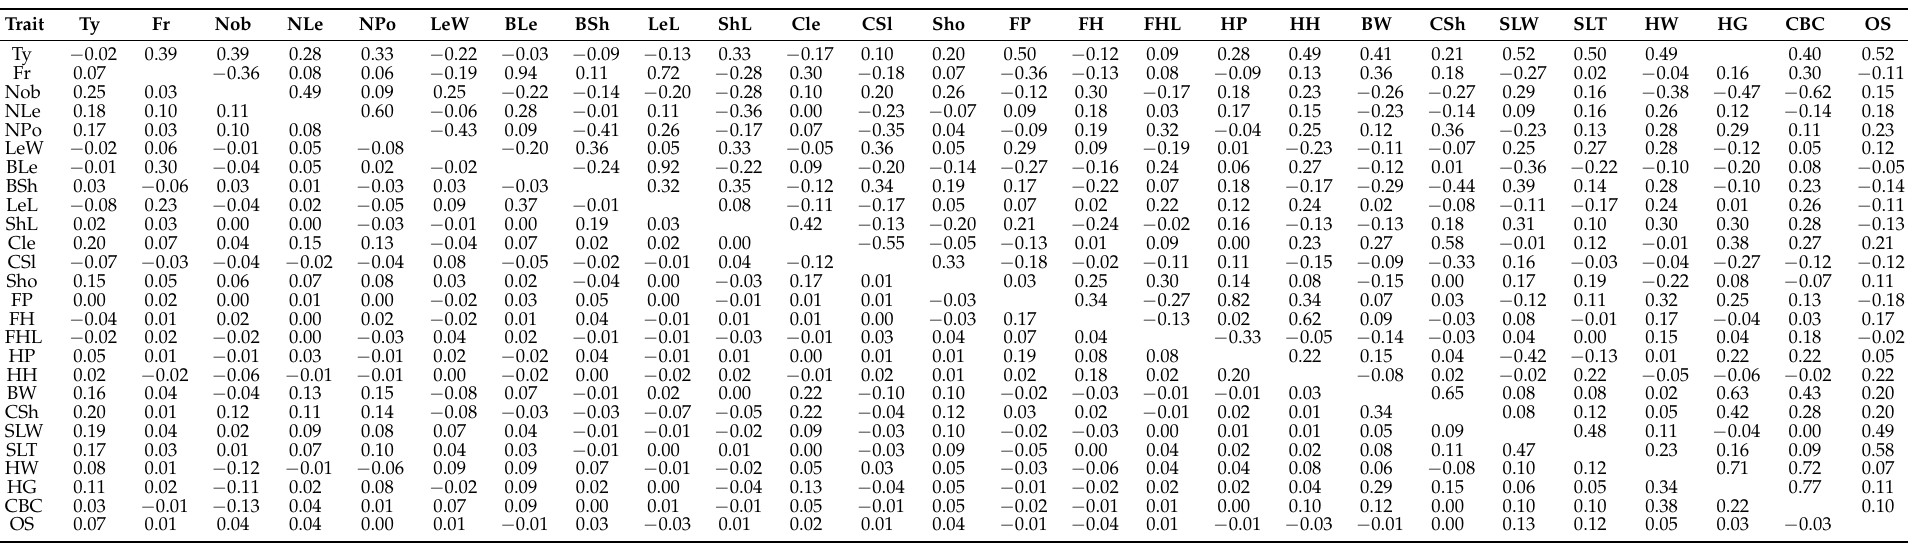
Table 4. Estimates of the genetic (above the diagonal) and phenotypic (below the diagonal) correlations, as computed by the two-trait